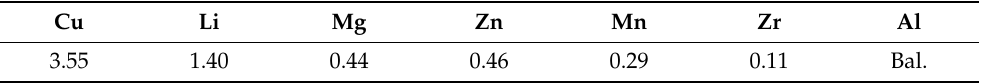
Table 1. Composition of the 2A97 alloy under investigation